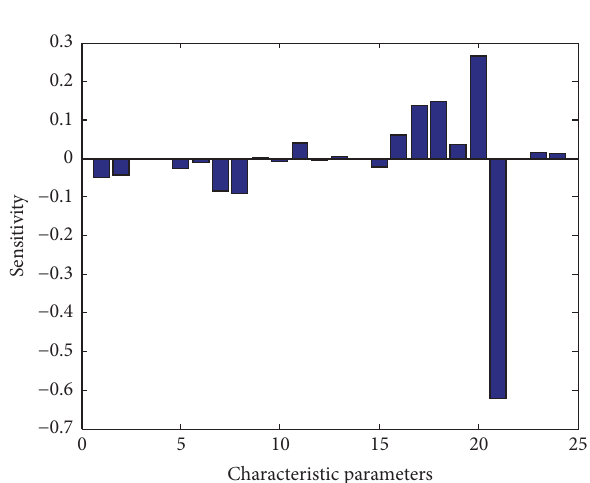
Figure 9: Sensitivity of each characteristic parameter.